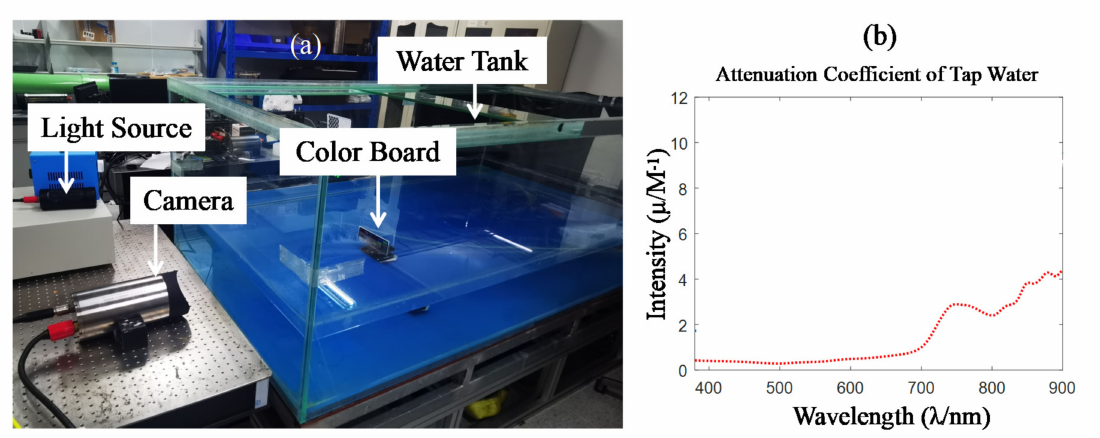
Figure 2. The experimental setup for color reproduction analysis of underwater images: ( a ) the experimental setup of capturing underwater images; ( b ) the attenuation coefficient of tap water.